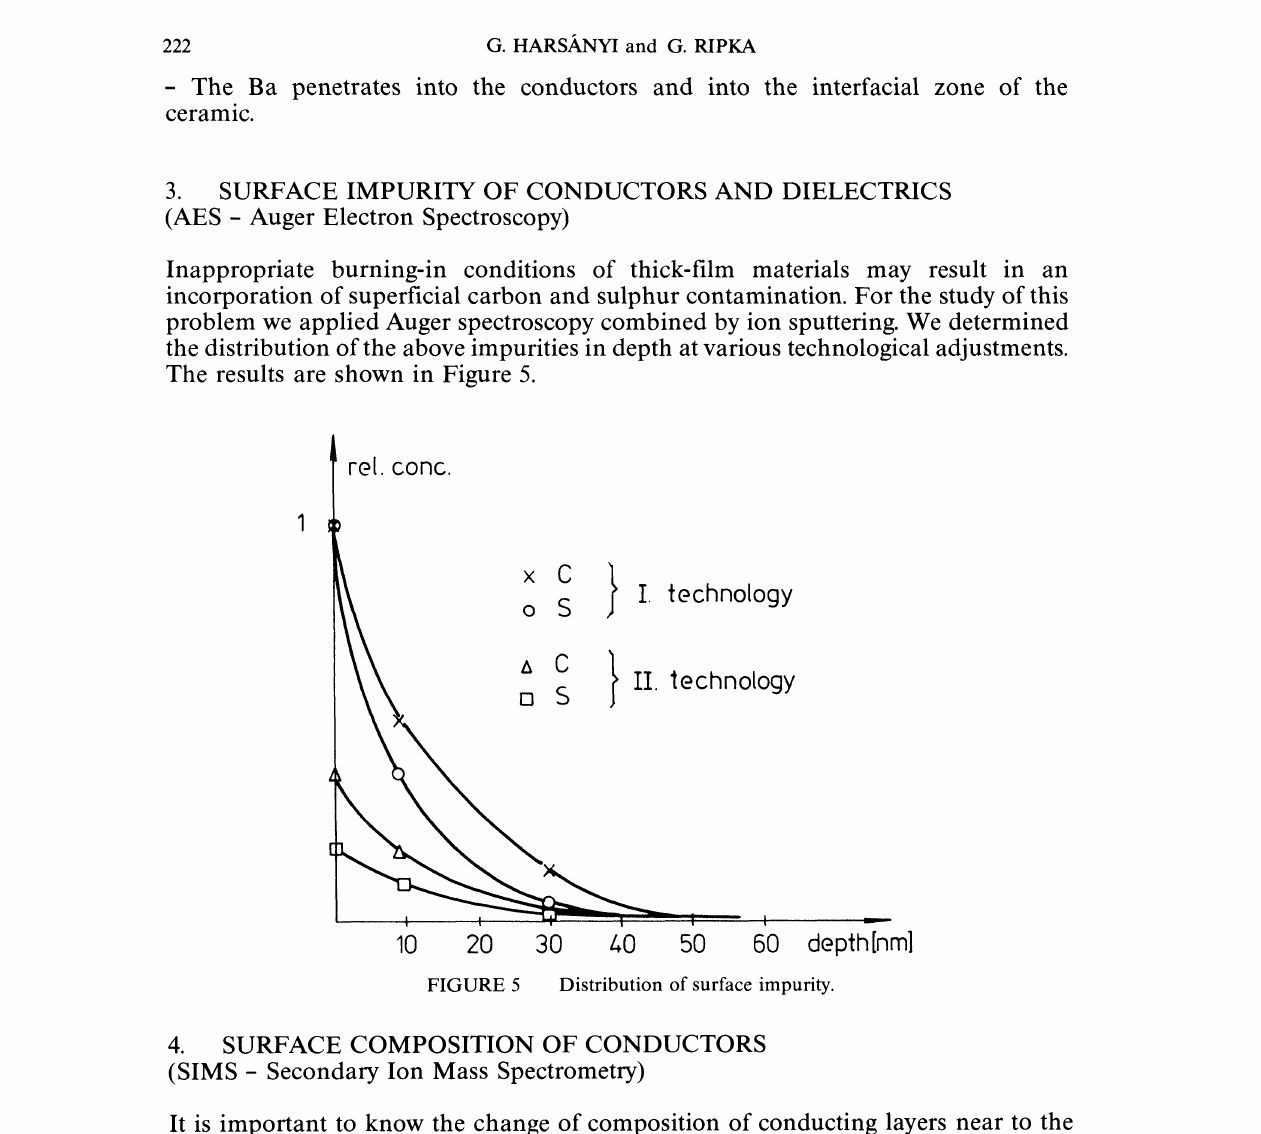
FIGURE 5 Distribution of surface